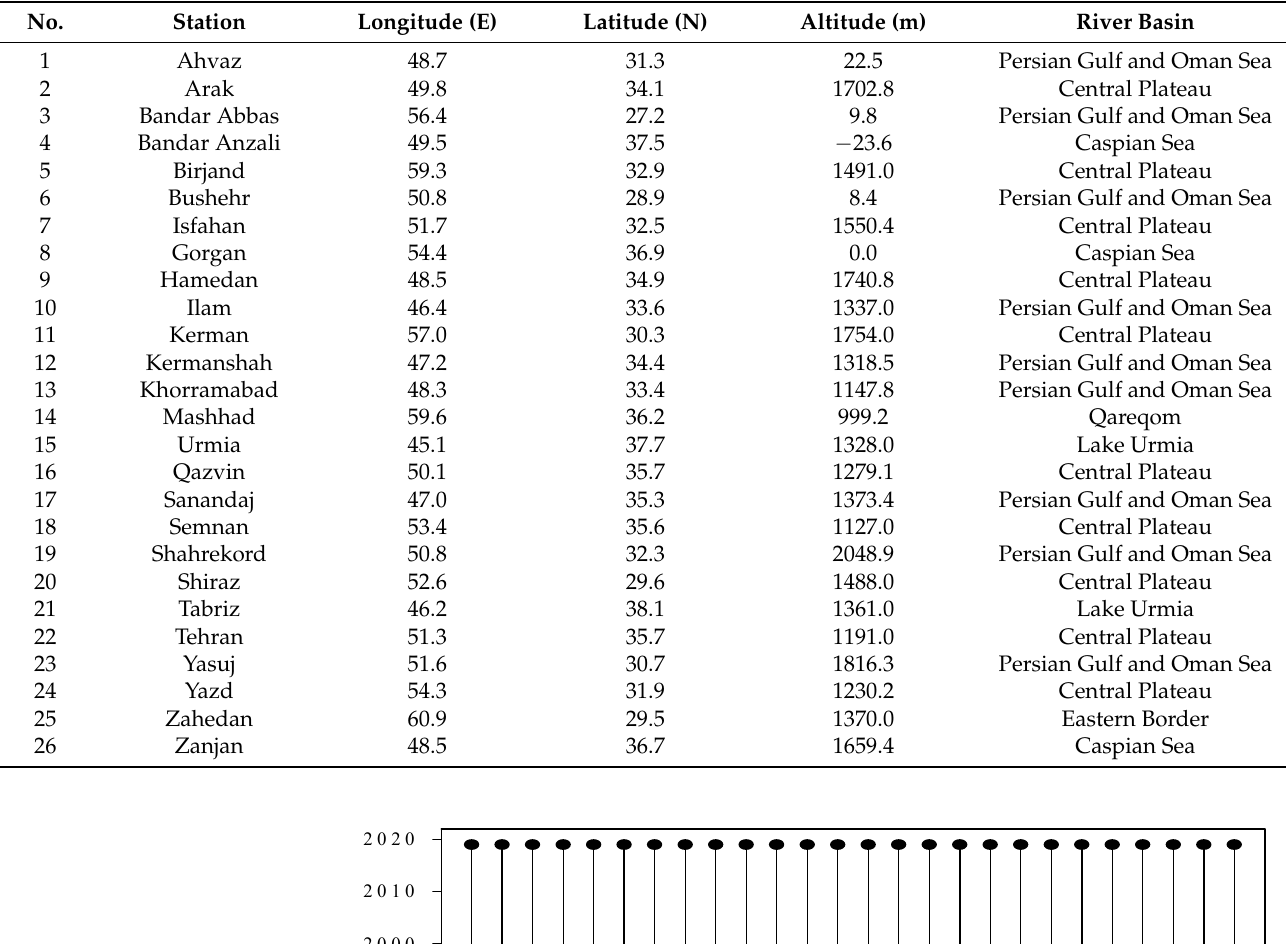
Table 1. Geographical characteristics and location of the selected stations.